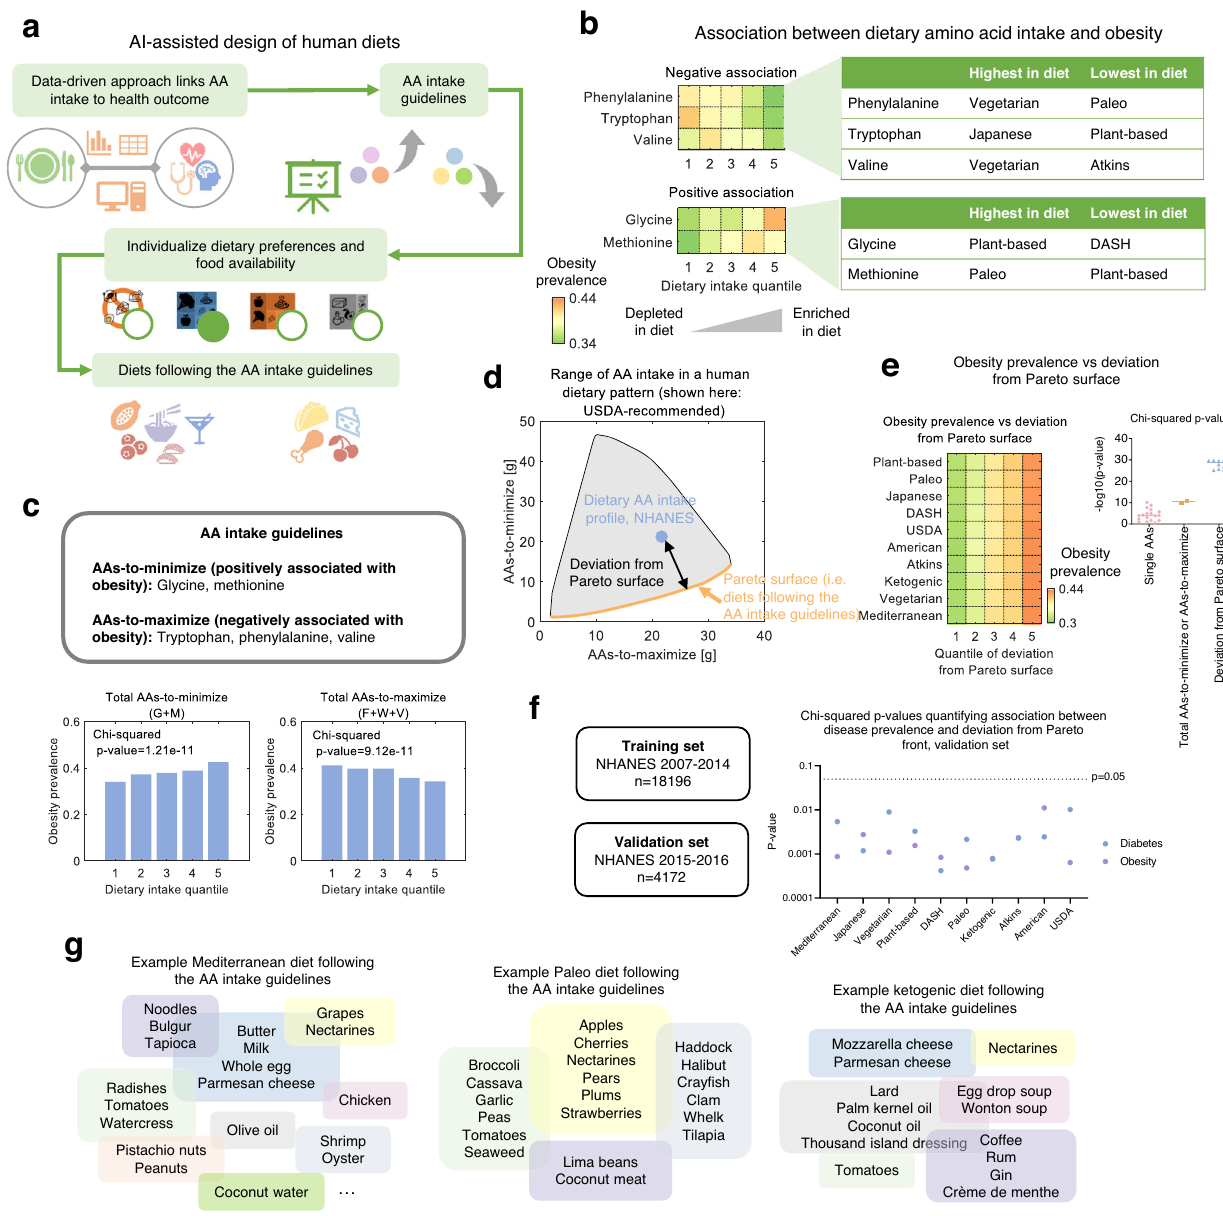
Fig. 5 | AI for dietary amino acid guidelines and personalized diet design. a Work fl ow for AI-assisted identi fi cation of dietary amino acid guidelines and designofpersonalizeddiets.ImagesusedwithpermissionfromMicrosoft. b Amino acids that positively or negatively associate with obesity prevalence in humans. c Identi fi cation and con fi rmation of amino acid intake guidelines based on the association betweendietaryamino acids and obesity.The p-values werecalculated by two-sided chi-squared test. d Rangesof intake of totalamino-acids-to-maximize andamino-acids-to-minimizeinthedietarypatternoftheUnitedStatesofAmerica Department of Agriculture (USDA) -recommended diet (grey shaded region) and the Pareto surface (orange bold curve) corresponding to the two guidelines, i.e.